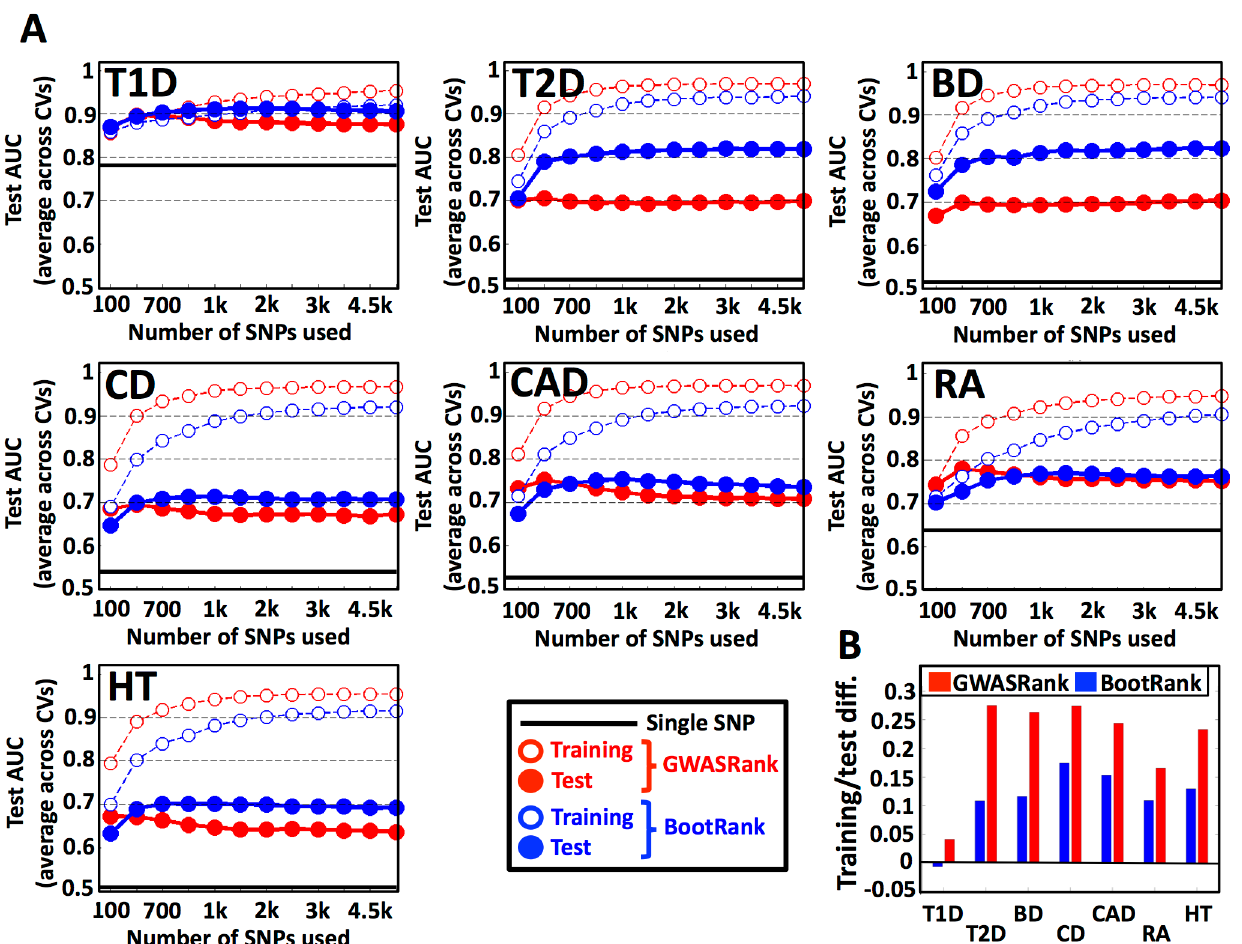
Figure 3. BootRank improves disease risk prediction for held-out test individuals. (a) For each disease (T1D, Type 1 diabetes; T2D, Type 2 diabetes; CD, Crohn’s disease; CAD, coronary artery disease; BD, bipolar disorder; RA, rheumatoid arthritis; HT, hypertension), shown are the training (empty circles) and test (filled circles) AUC values as a function of different numbers of SNPs used in the model (x-axis) when employing either GWASRank (red) or BootRank (blue) to rank SNPs. (b) The mean difference between training AUC and test AUC is shown for all diseases for GWASRank (red) or BootRank (blue).